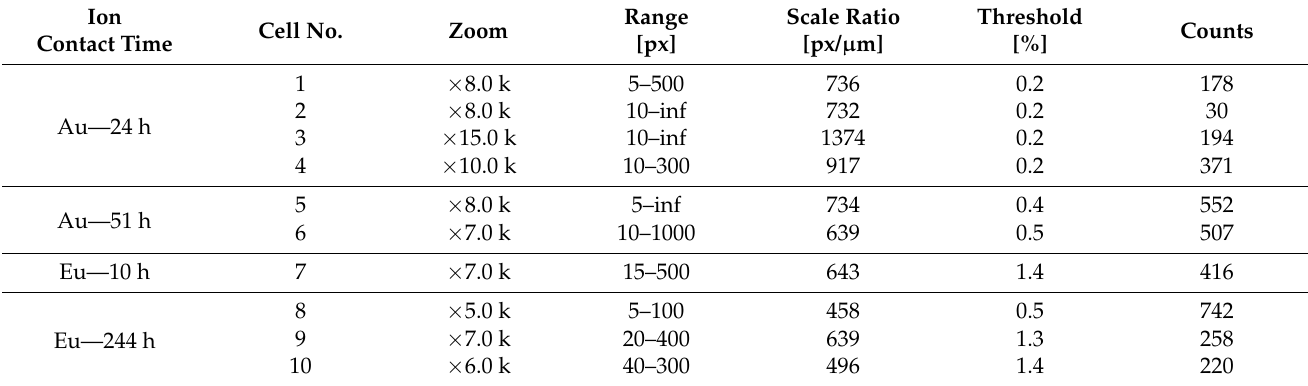
Table 1. Underlying TEM image settings for the determination of Au- and Eu-NP sizes in the complete vegetative cells (Au) and heterocysts (Eu), respectively (inf =